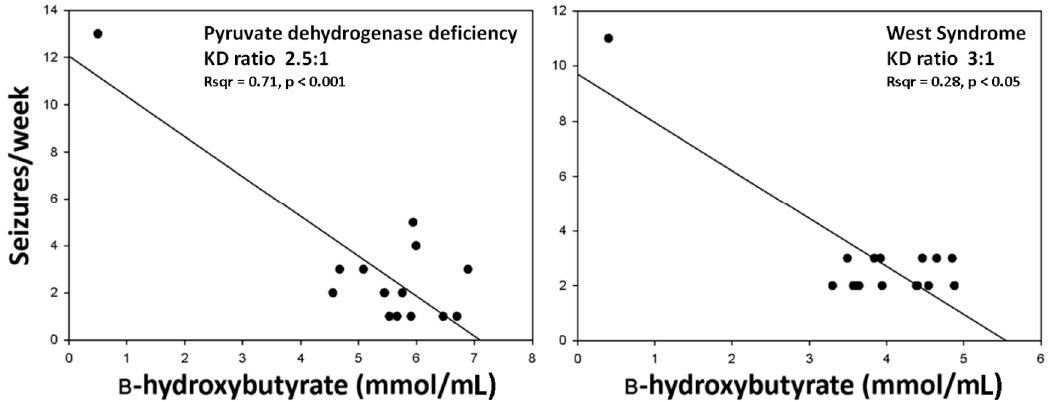
Figure 4. The relationship between ketosis and seizure reduction was analyzed by linear regression in two patients, whose characteristics are reported in Table 1 (#2 and #6).